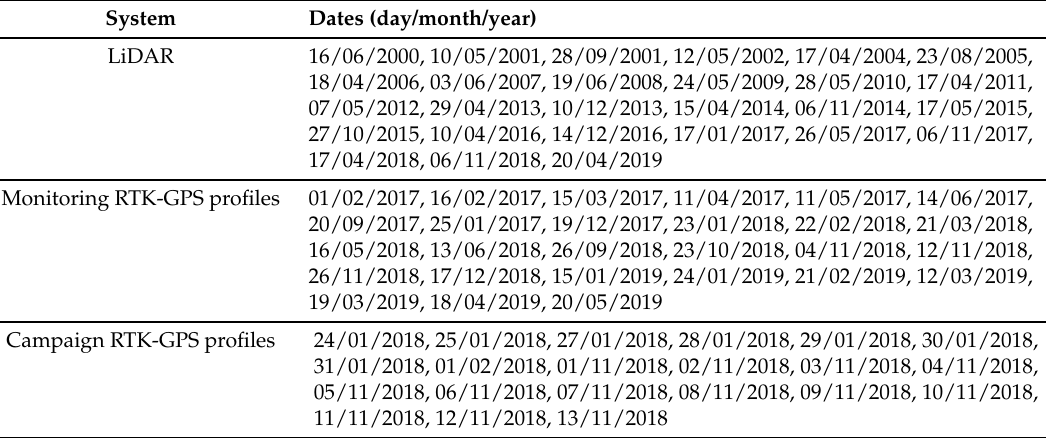
Table 1. Timeline of the monitoring surveys used in this study. Italicized dates correspond to the surveys for the CREST